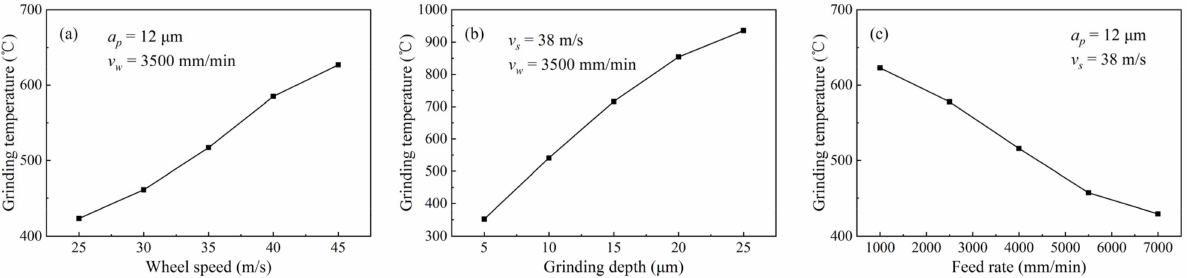
Figure 7. Grinding temperature under different grinding parameters: ( a ) Wheel speed; ( b ) Grinding depth; ( c ) Feed